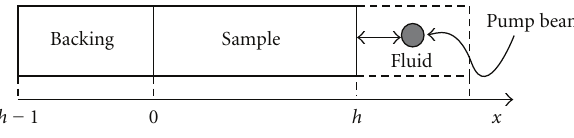
Figure 4: Schema of the PASL sample.